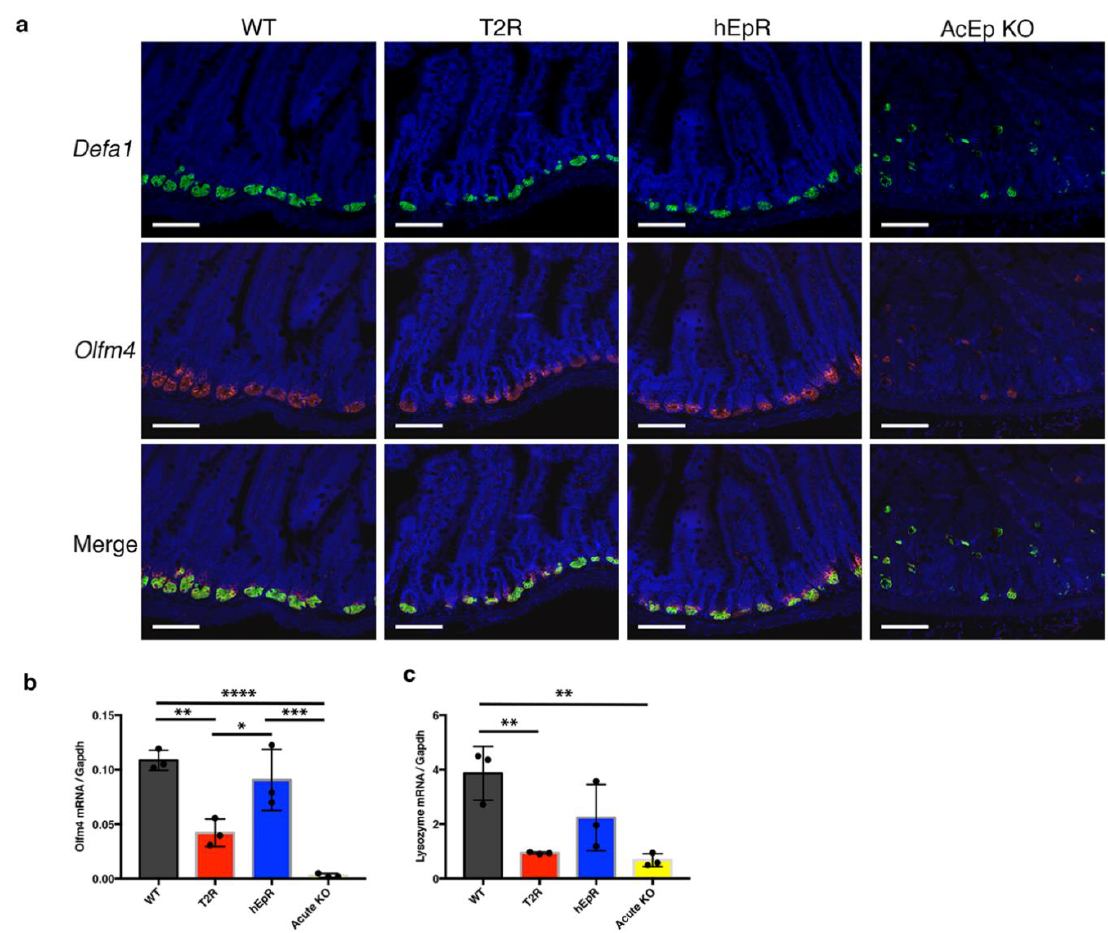
Figure 5. Diminished paneth cells and stem cells in TROP2 rescue mice. ( a ) Paneth cells (Defa1 + , green) and stem cells (Olfm4 + , red) were visualized in jejunum by RNA-Scope in situ hybridization and fluorescence microscopy. Scale bars, 100 μm. ( b,c ) qPCR analysis was performed to determine relative levels of mRNA expression in ileal tissue normalized to glyceraldehyde-3-phosphate dehydrogenase (GAPDH) mRNA expression. Values depicted represent means ± SE of samples from 3 different mice ( n = 3). * p < 0.05, ** p < 0.01, *** p < 0.001, **** p < 0.0001 as determined using one-way ANOVA with Tukey’s multiple comparison test.